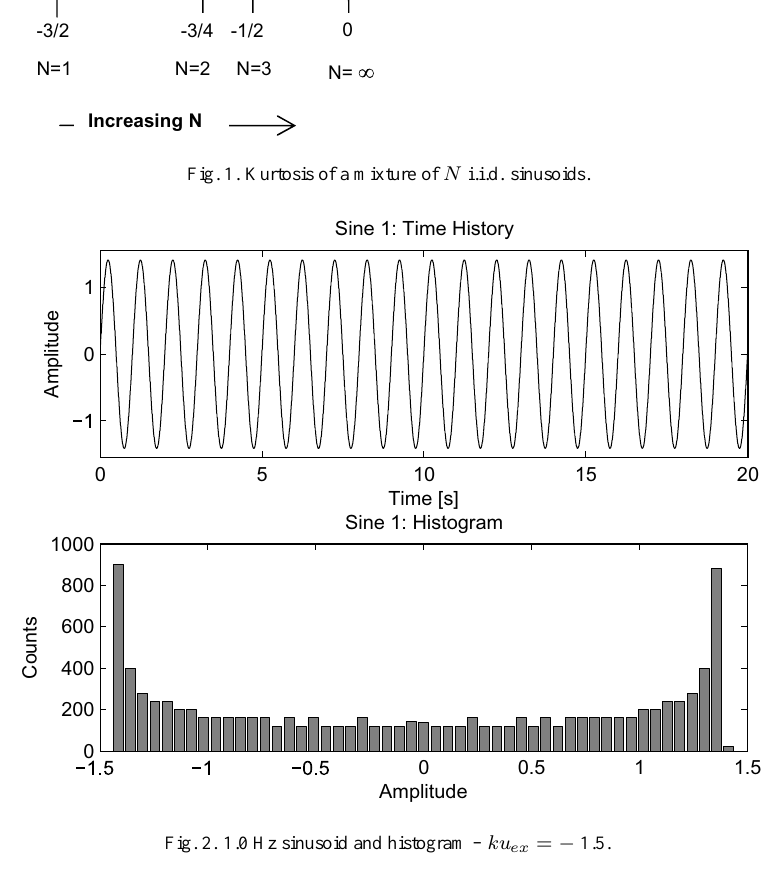
Fig. 2. 1.0 Hz sinusoid and histogram – ku ex = −